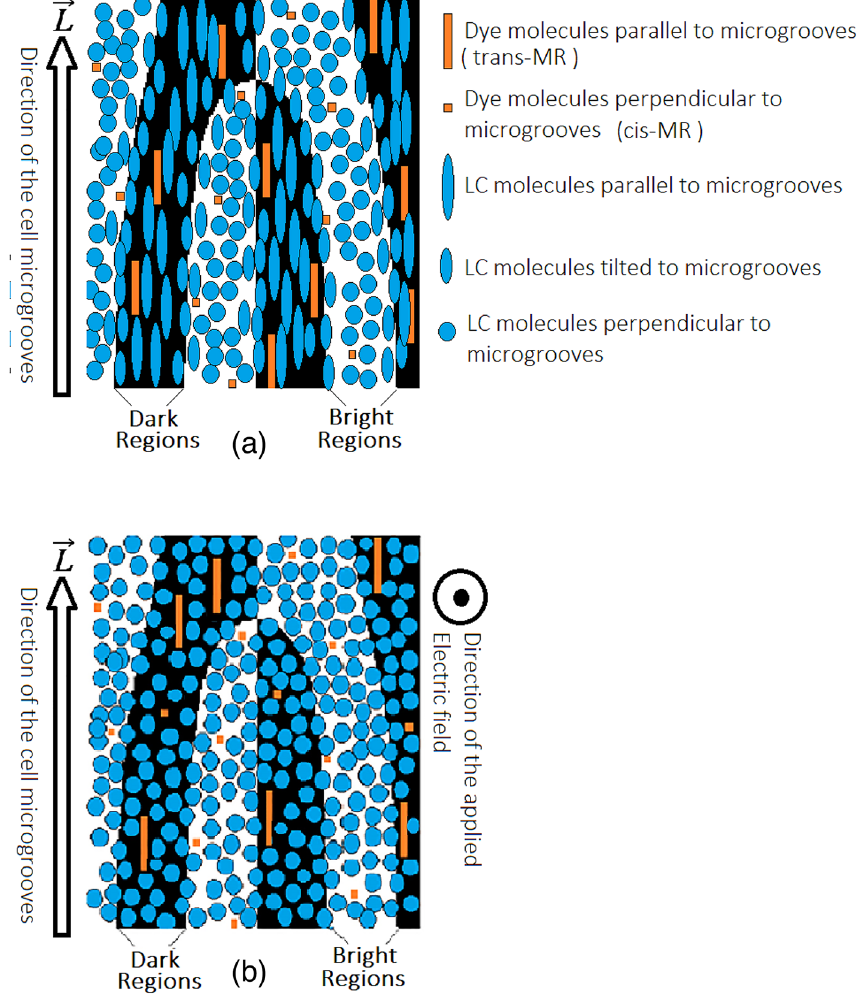
0 Figure 6. Top view for the planar cell: the rubbing angle is α ◦ . ( a ) LC director distribution at 0 V, in the = border of the dark and the bright regions the orientation of the LC molecules due to their associated behavior continuously and gradually passes from the parallel to perpendicular state, which in turn causes a quasi- sinusoidal phase state. ( b ) By applying a proper voltage to the sample, the director of all the LC molecules reorients and remains perpendicular to the cell surface but due to the low dipole moment of dye molecules they do not reorient under 22-V applied voltages except a little